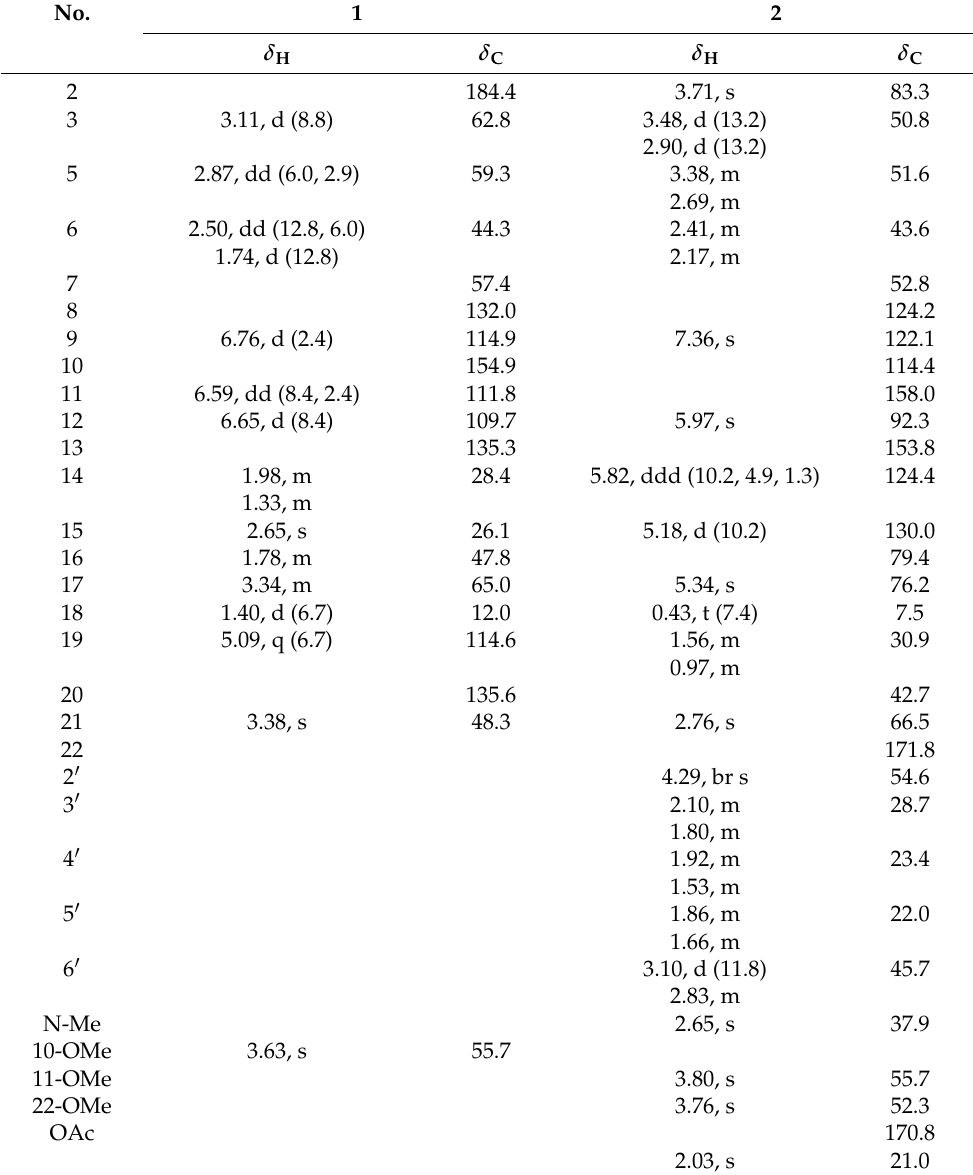
Table 1. 1 H-NMR (600 MHz) and 13 C-NMR (150 MHz) spectroscopic data of compounds 1 and 2 in CDCl 3 ( δ in ppm, J in